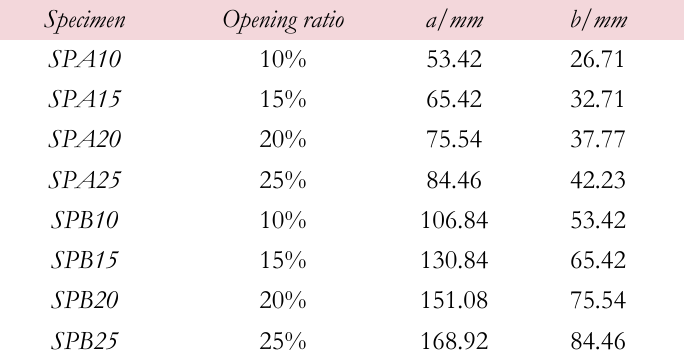
Table 2: Parameters of Shearing couple beam damper.